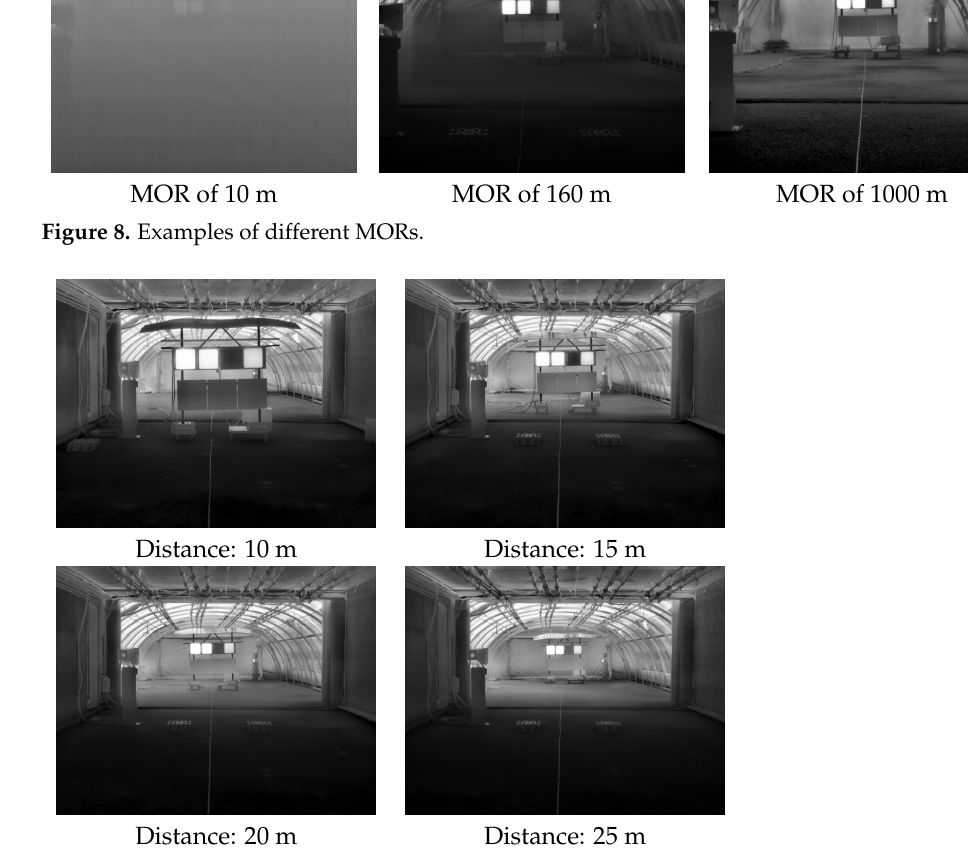
Figure 9. The four different camera-to-target distances used during static scenarios.